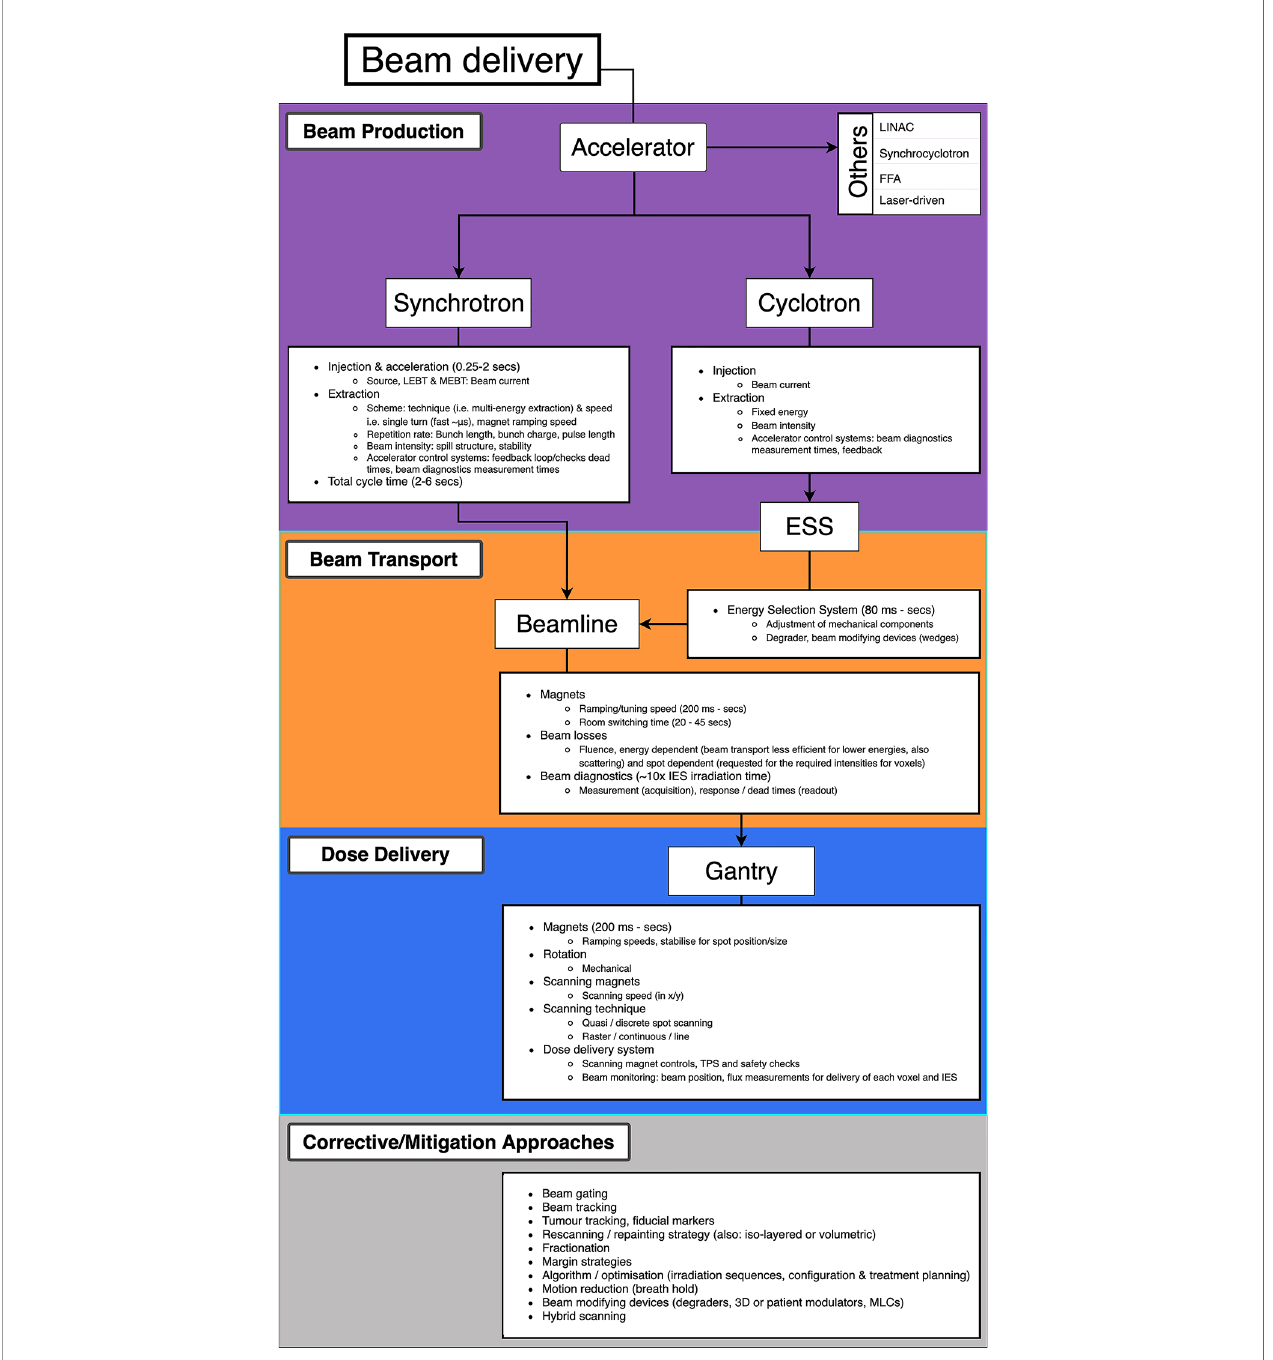
FIGURE 2 | Overview of PBS beam delivery and different motion mitigation strategies. Breakdown of contributions to the BDT from the beam production, beam transport and dose delivery